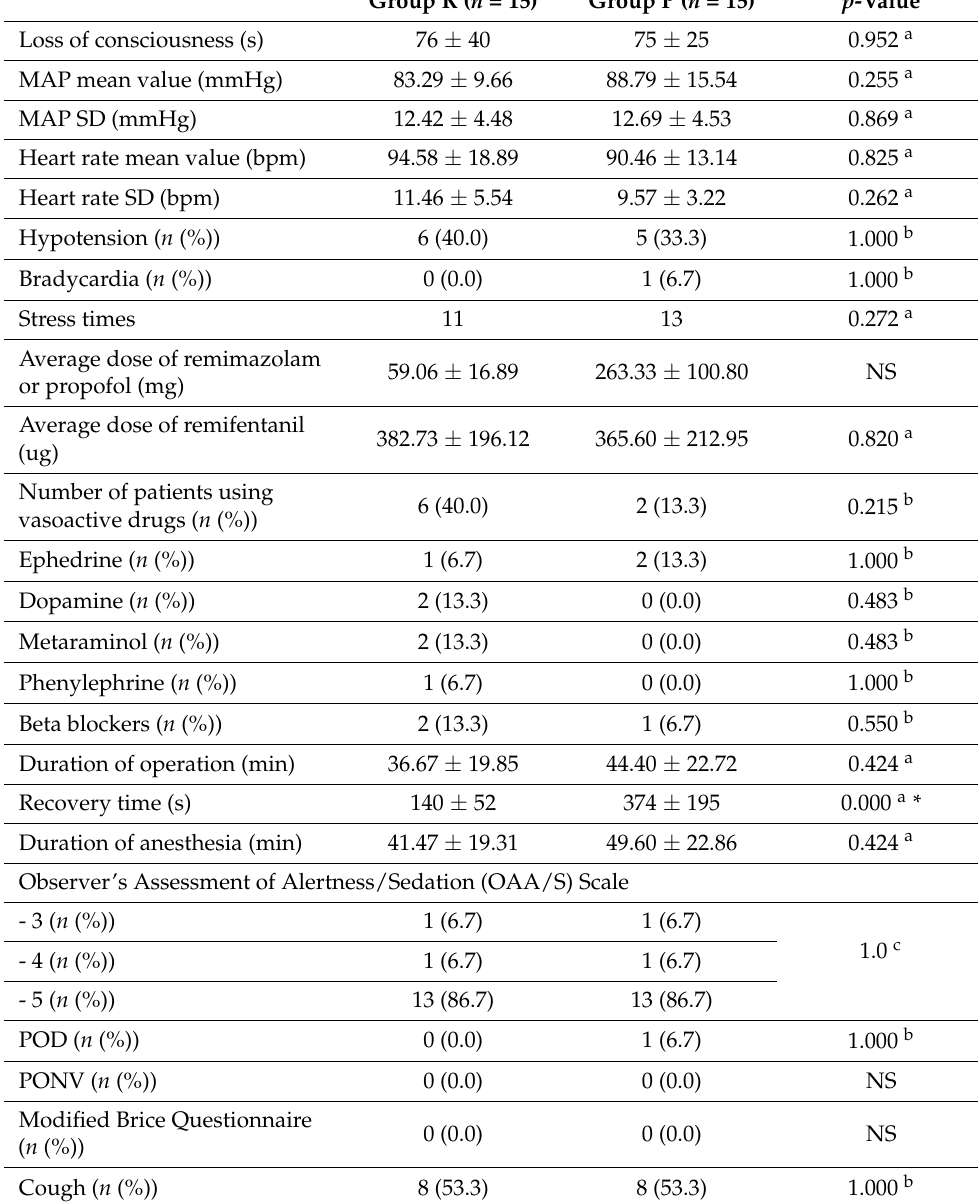
Table 2. Parameters during and after